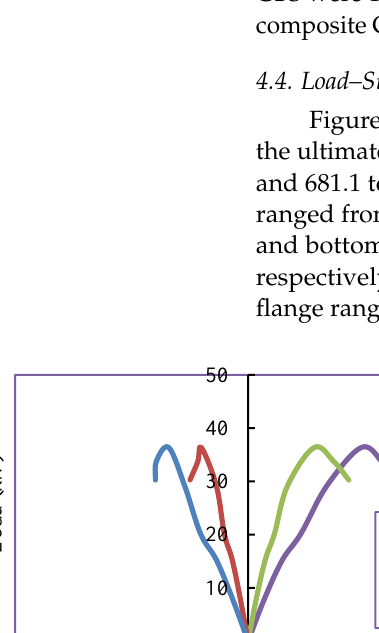
Figure 9. Evaluation of the yield and ultimate displacements [43]. Table 3. Ductility values of CFS beams.